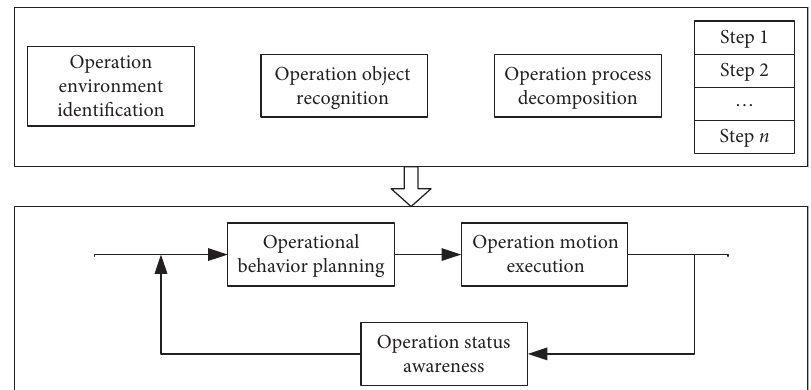
Figure 12: Schematic diagram of robot autonomous operation.